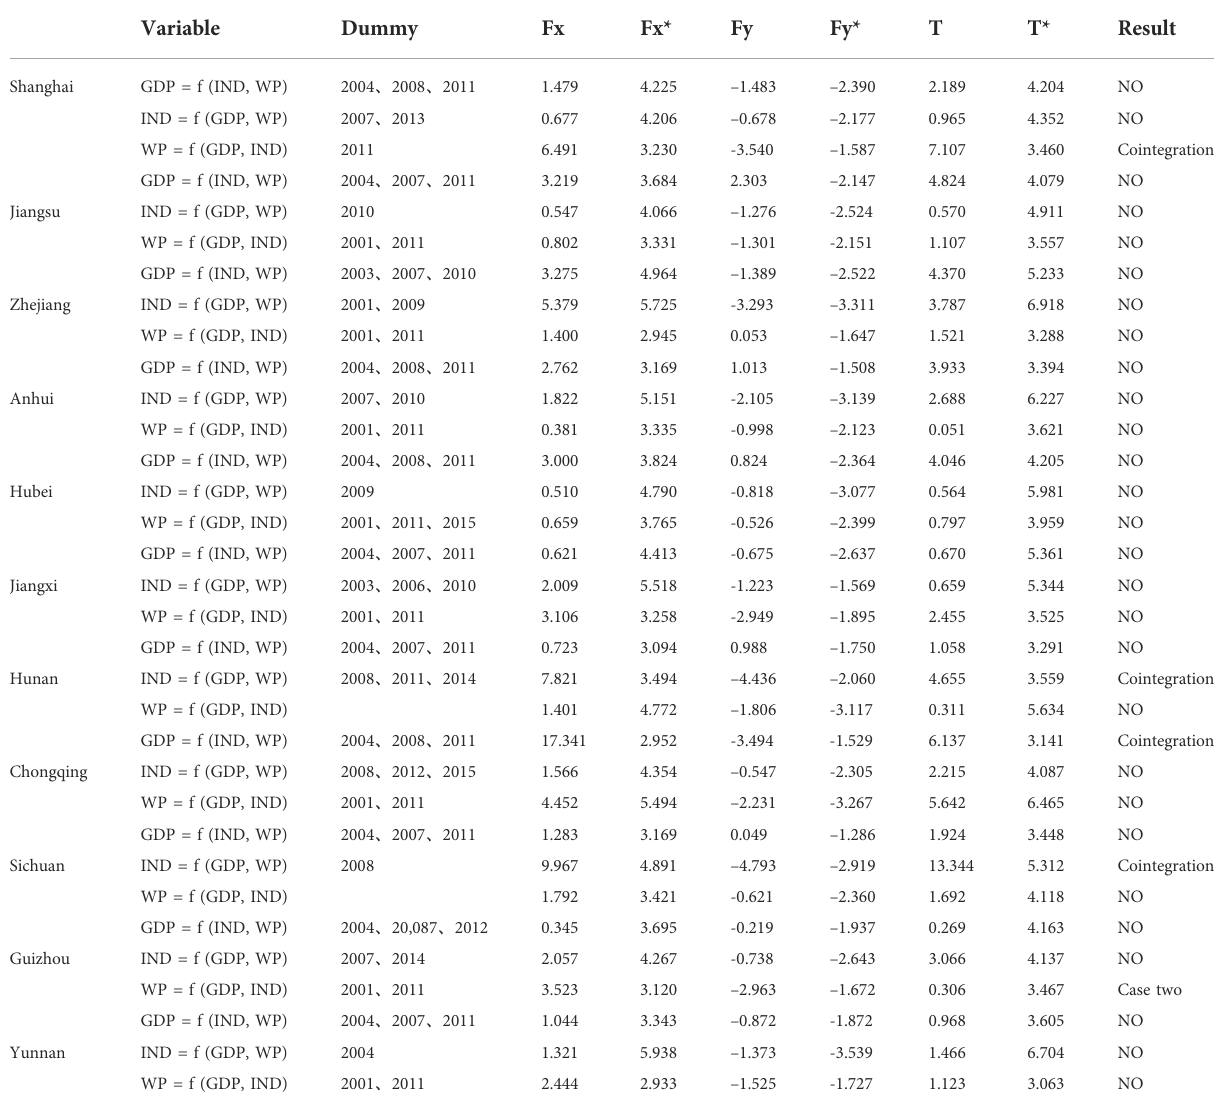
TABLE 3 Bootstrap ARDL model cointegration test results